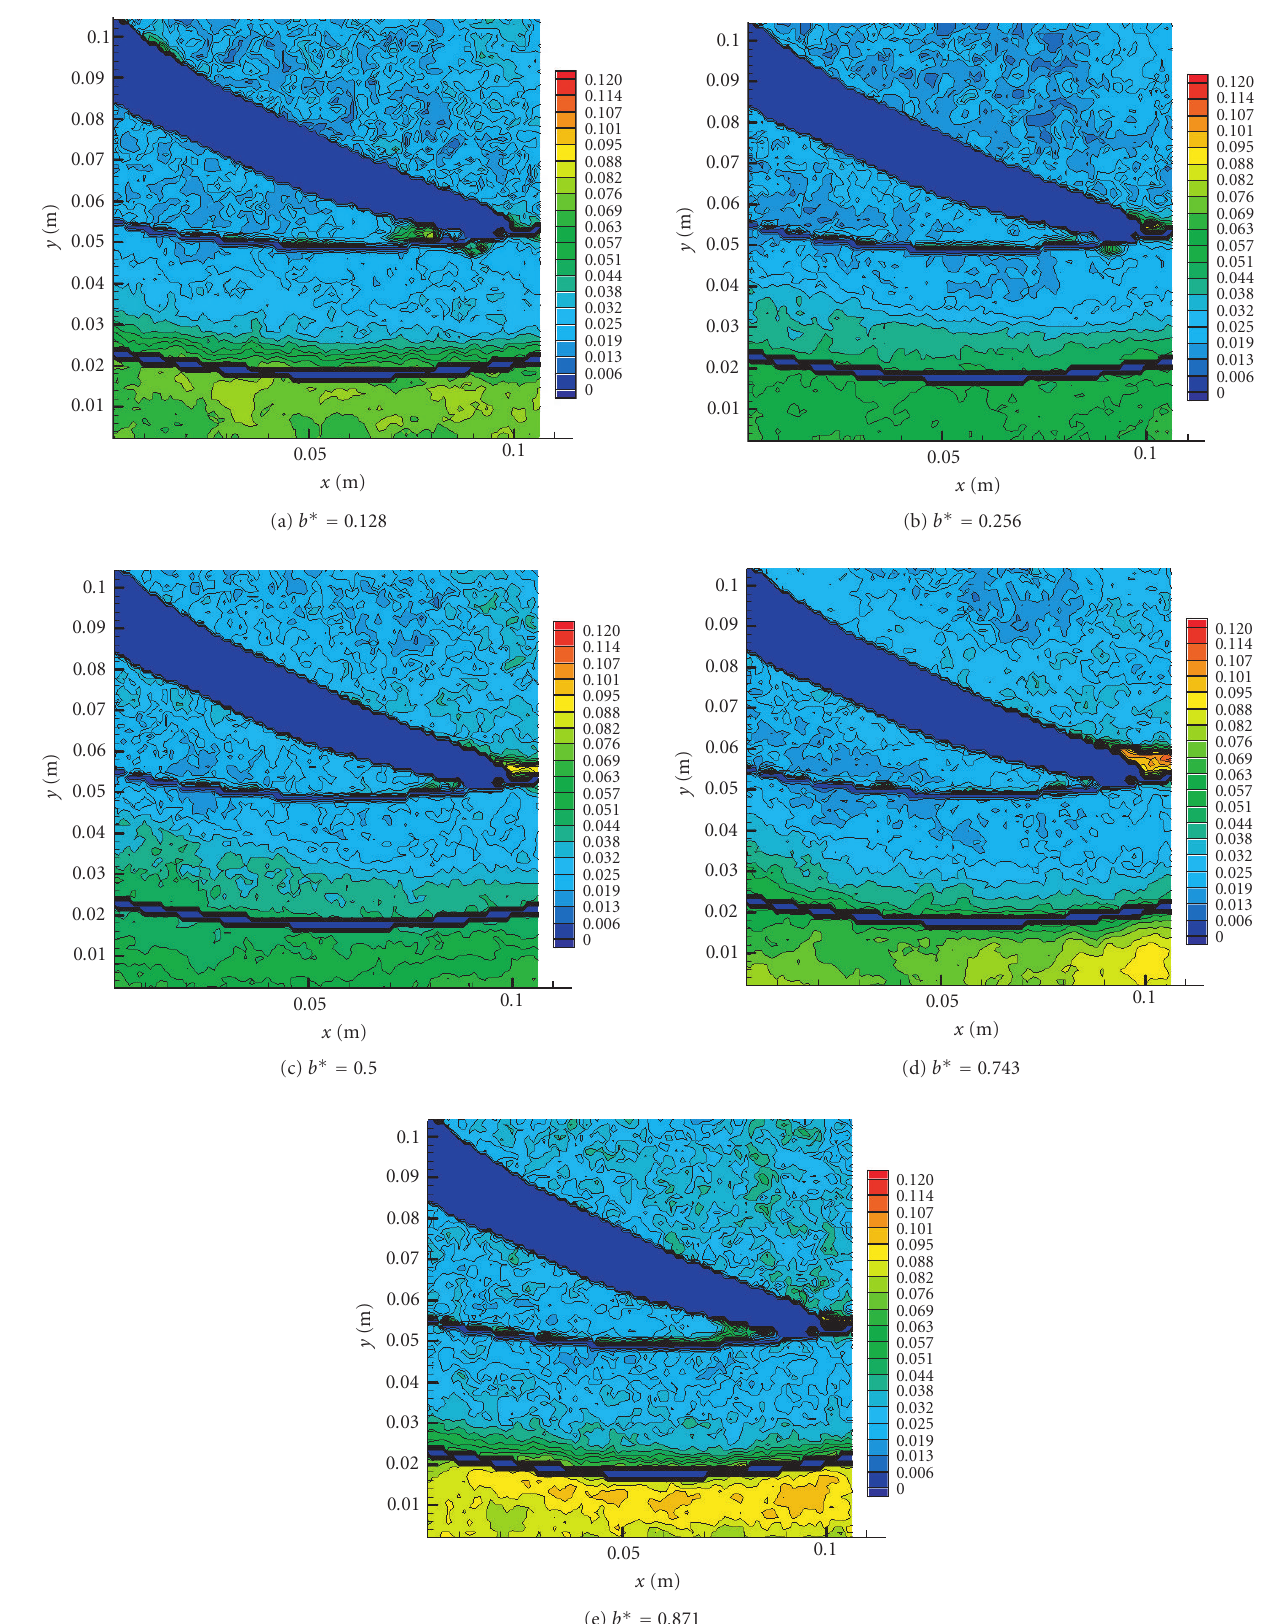
Figure 5: Velocity fluctuation